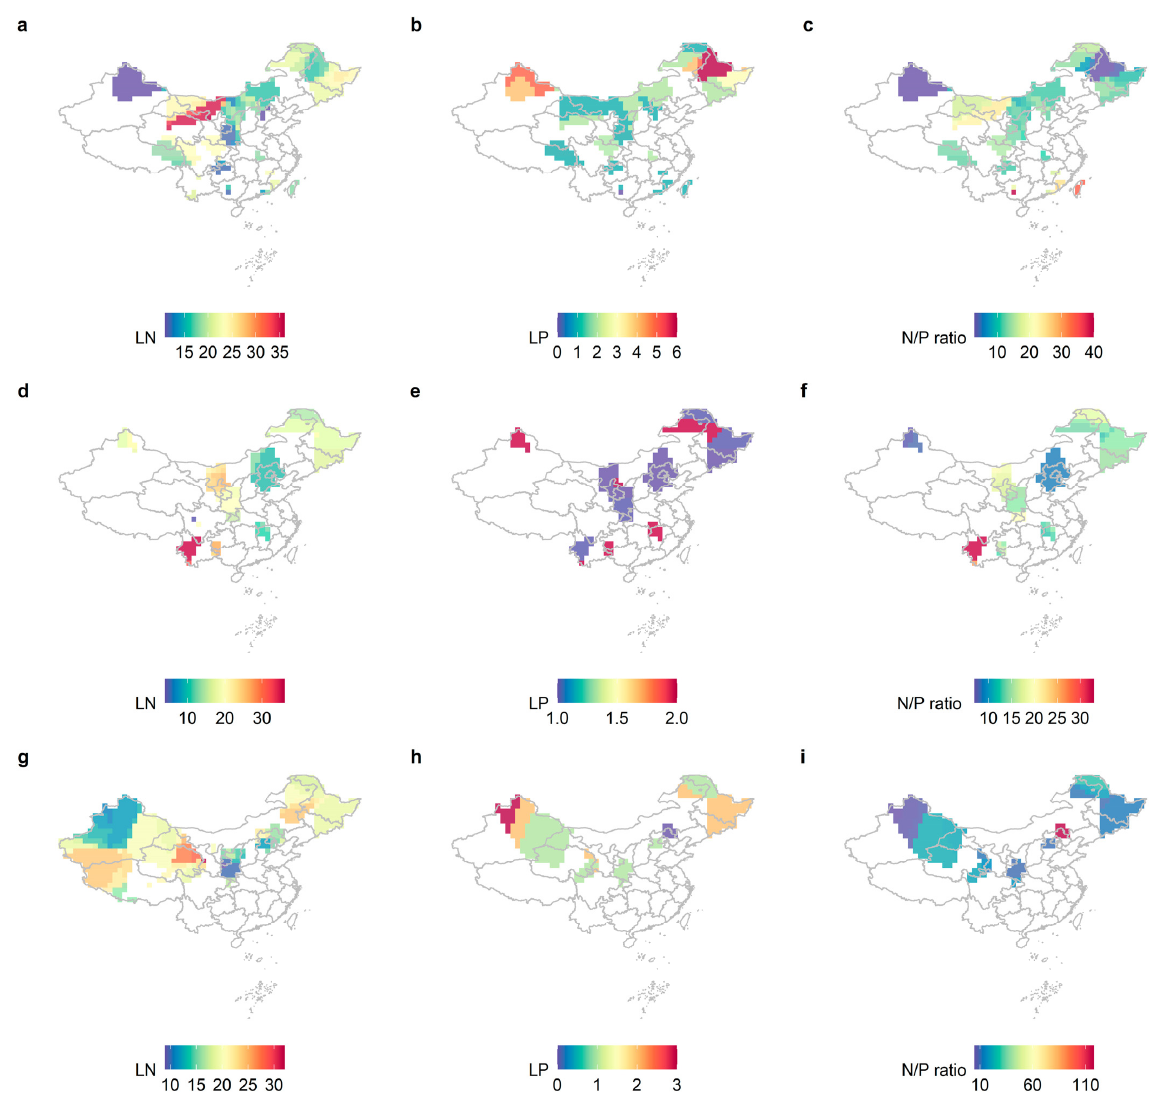
Figure 1. The distribution patterns of LN, LP, and N/P at different life forms in China with a spatial resolution of 1 × 1 km were studied by kernel density estimation. ( a ) LN of the tree levels; ( b ) LP of the tree levels; ( c ) N/P of the tree levels; ( d ) LN of the shrub levels; ( e ) LP of the shrub levels; ( f ) leaf N/P of the shrub levels; ( g ) LN of the herb levels; ( h ) herb levels LP; ( i ) herb levels N/P.